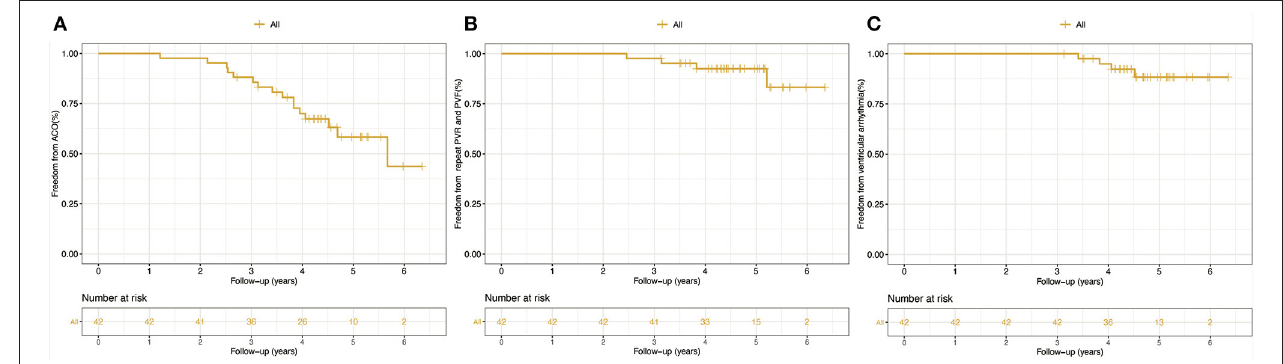
FIGURE 2 | Kaplan-Meier analysis for clinical outcomes. (A) Freedom from ACO. (B) Freedom from repeat PVR and PVF. (C) Freedom from new-onset arrhythmia. ACO, adverse clinical outcomes; PVR, pulmonary valve replacement; PVF, pulmonary valve failure.